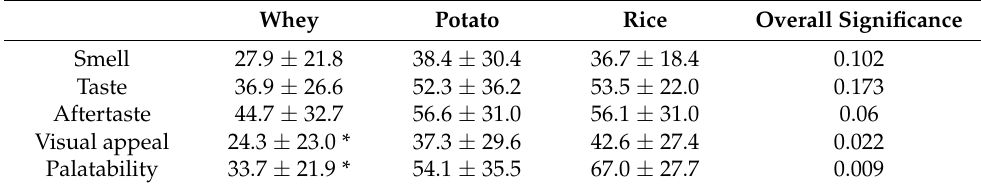
Table 4. Mean (±SD) scores from the VAS questions on Table 4. Mean ( ± SD) scores from the VAS questions on palatability.